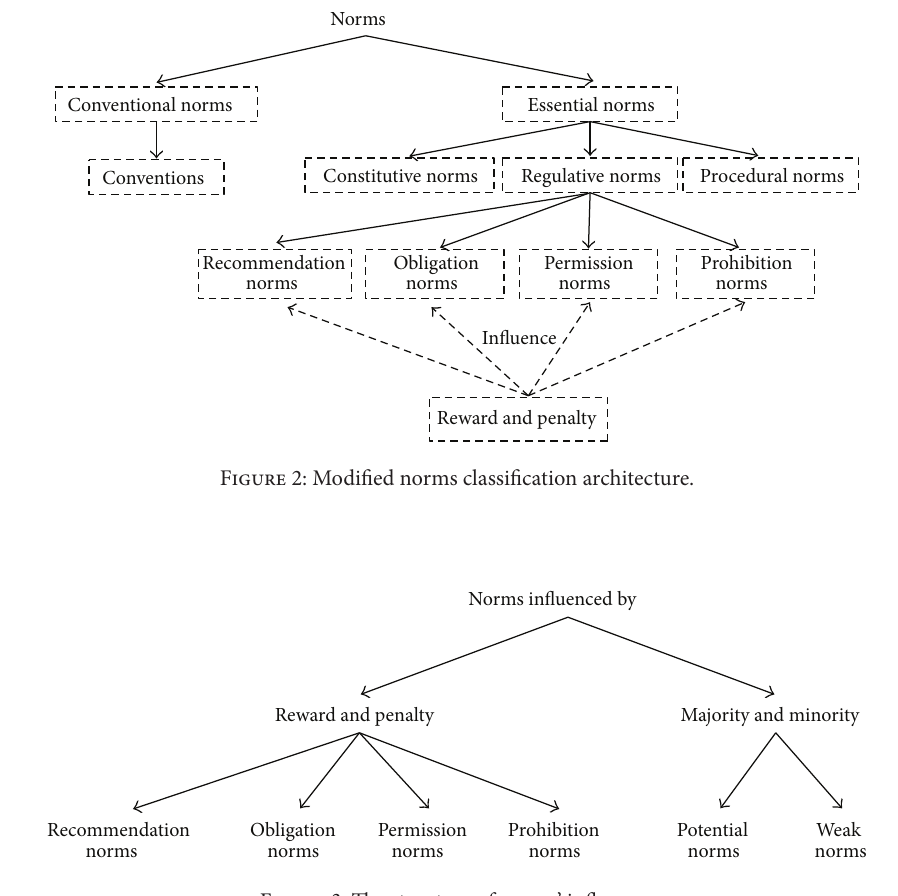
Figure 3: The structure of norms’